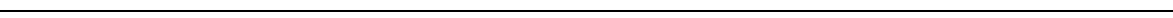
Fig. 4 Capability of mULM parameters to distinguish tumors with different vascular phenotypes. a Results of the inter-group comparison of all parameters using the one-way ANOVA and Bonferroni post-hoc test. Differences between parameters with p < 0.01 are highlighted in dark green. Differences with p < 0.05 are indicated in light green. Only the parameters which could discriminate all three tumor models were used to generate confusion matrices. b Confusion matrices were generated to assess the capability of the parameters to correctly assign individual tumors to their according group. The numbers in the diagonal elements of the matrix represent correct classi fi cations (highlighted in green), the remaining numbers indicate false assignments (highlighted in pink; see explanatory example in the upper row). Confusion matrices of the maximum of distances to the closest vessel and of the maximum of distances to vessel with low velocities reveal a correct classi fi cation in all cases (100%). For the variance of distances to the closest vessel, 83% correct classi fi cation is achieved. c Although several parameters alone already allowed a correct assignment of all tumors, parameter combinations may be required when investigating more heterogeneous tumor populations. Therefore, a correlation matrix (Pearson ’ s correlation coef fi cient ( r )) of all mULM parameters was generated to indicate the parameters providing complementary information. The highly discriminating distance parameters strongly correlated and thus, their combination may not be advantageous. However, the parameter local fl ow direction entropy showed a low correlation with the distance parameters and could be selected as a potential candidate for a multi-parameter